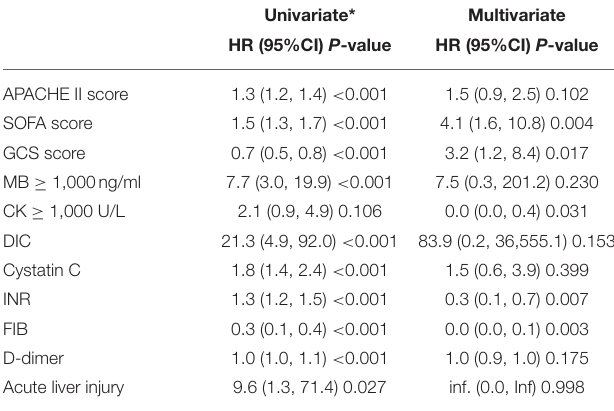
TABLE 3 | Risk factors for 90-day mortality in EHS complicated with AKI patients. Univariate*